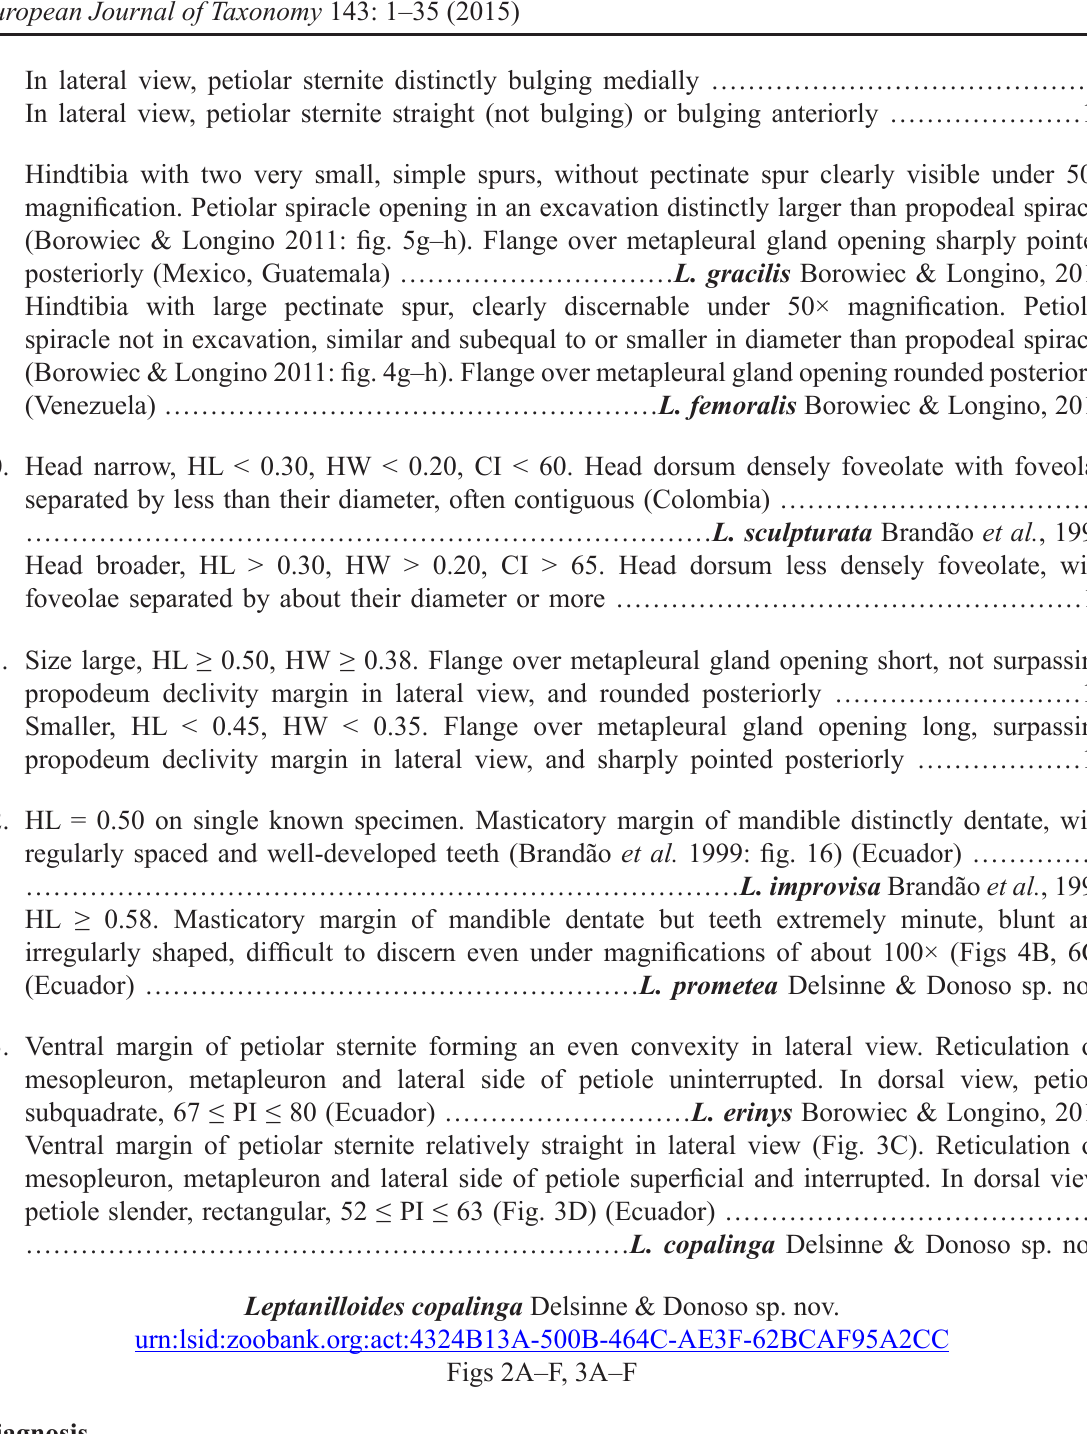
petiole slender, rectangular, 52 ≤ PI ≤ 63 (Fig. 3D) (Ecuador)